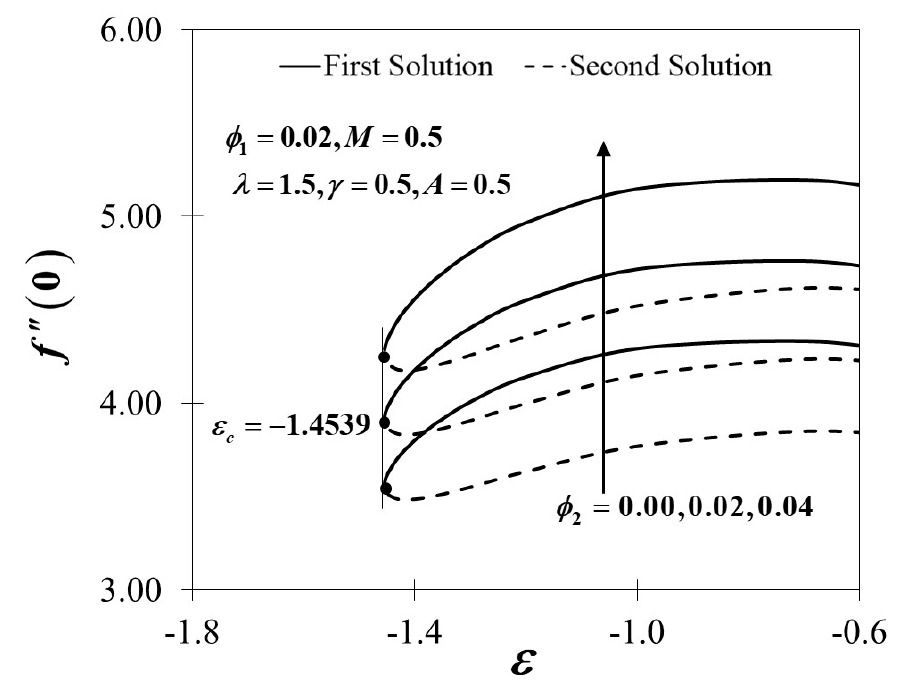
′′ for different values of